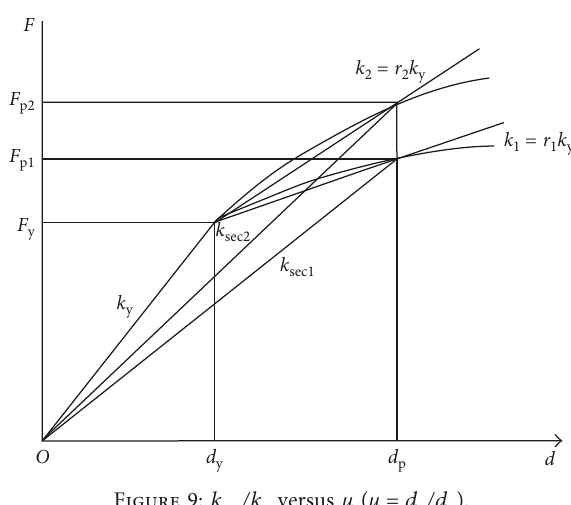
/k versus μ ( μ � d sec y